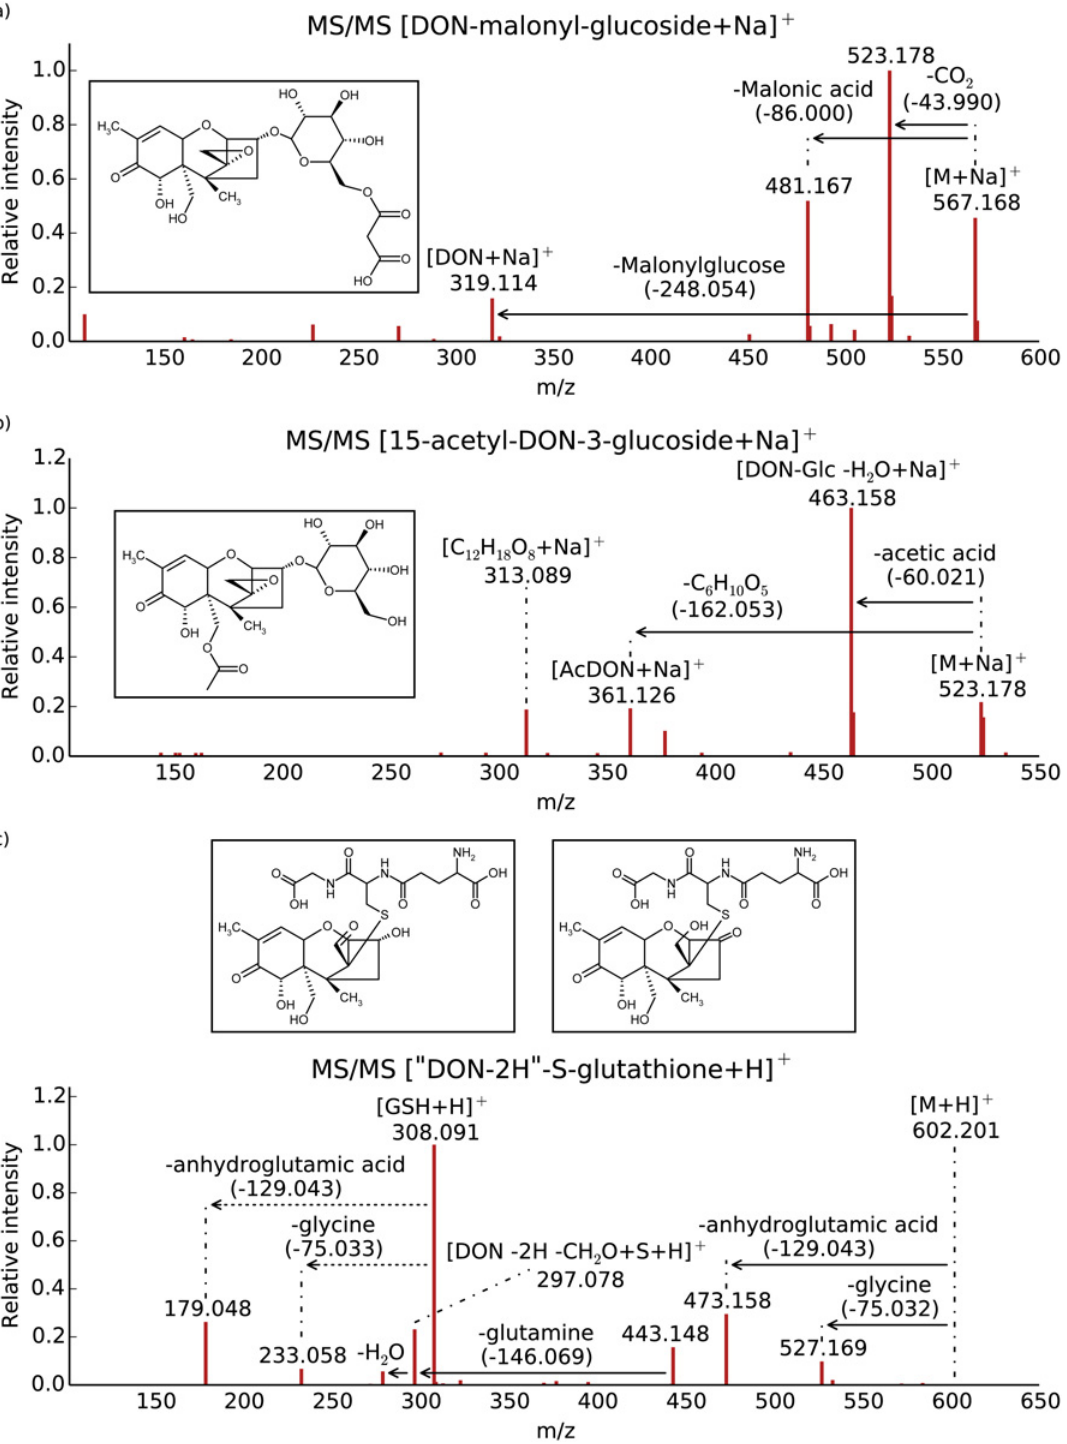
Fig 2. LC-HRMS/MS spectra of the DON biotransformation products. a) DON-malonylglucoside, b) 15-acetyl-DON-3- β -D-glucoside and c) “ DON-2H ” -S glutathione (GSH), all LC-HRMS/MS spectra are shown with a proposed structure formula.